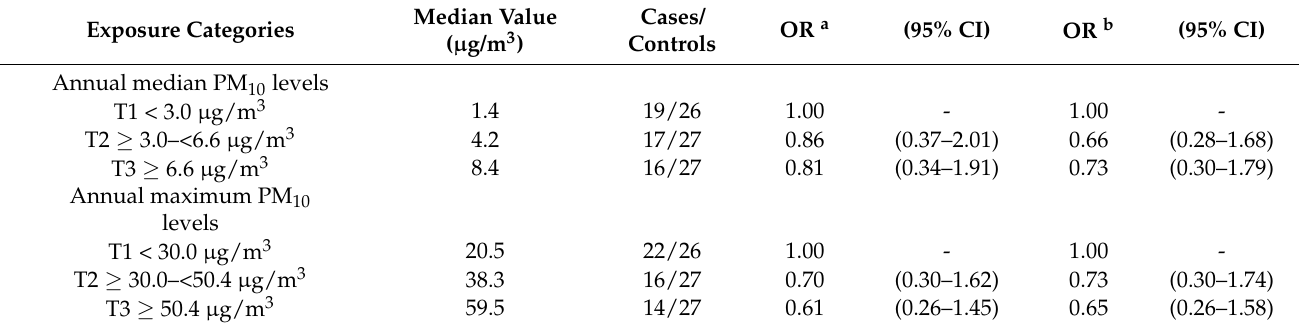
Table 4. Risk of amyotrophic lateral sclerosis according to particulate matter (PM 10 ) exposure using tertile distribution.